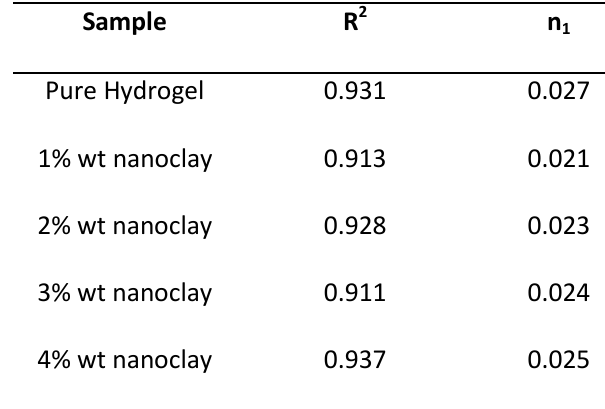
Obtained results by Higuchi